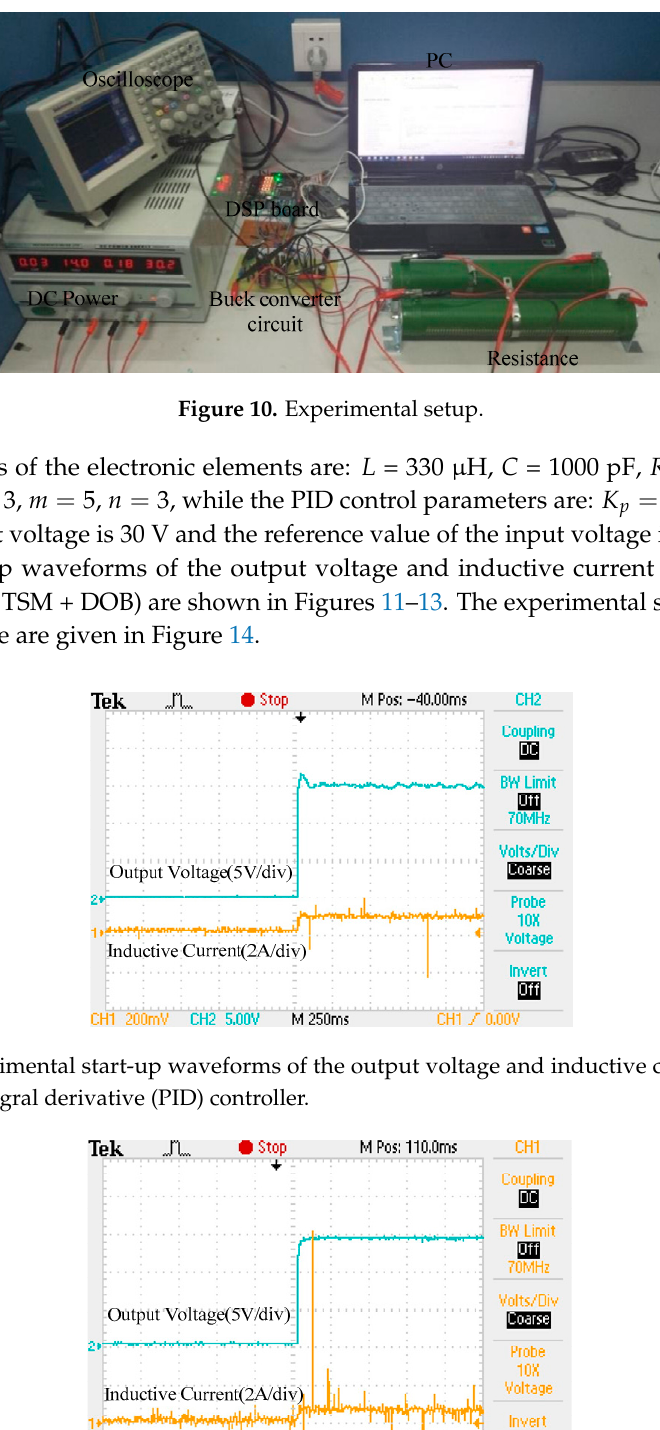
Figure 9. The block diagram of the experimental platform.